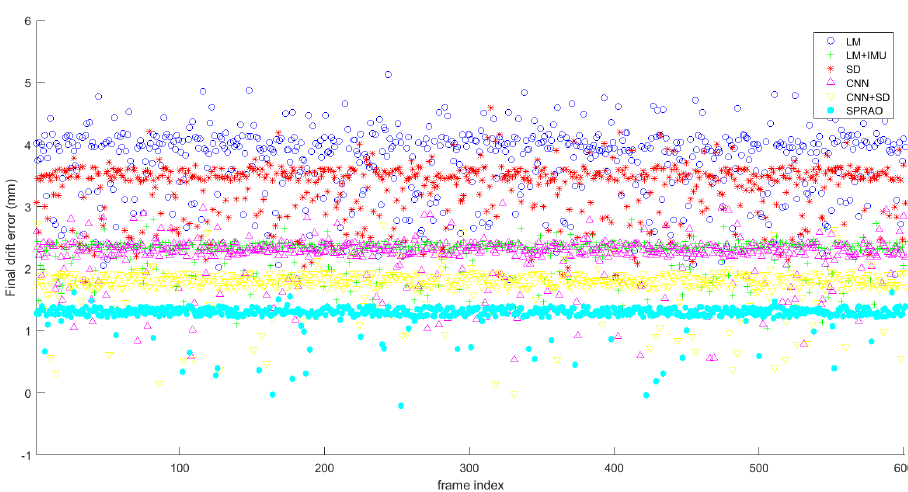
Figure 26. Reconstruction results of dataset DB5.